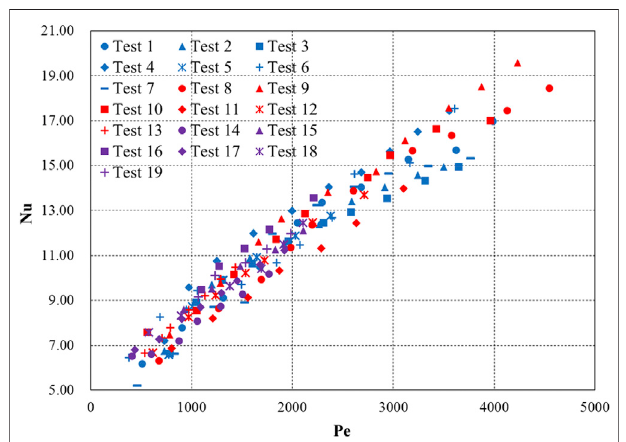
FIGURE 3 | Heat-transfer results from the NCCL experiments.